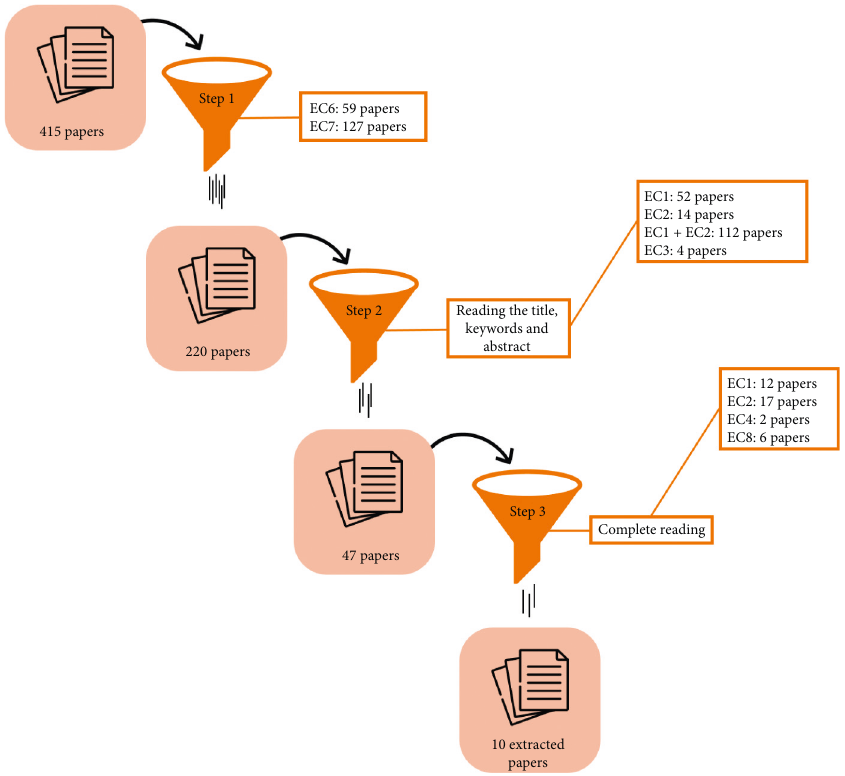
Figure 1: Papers selection process with the search